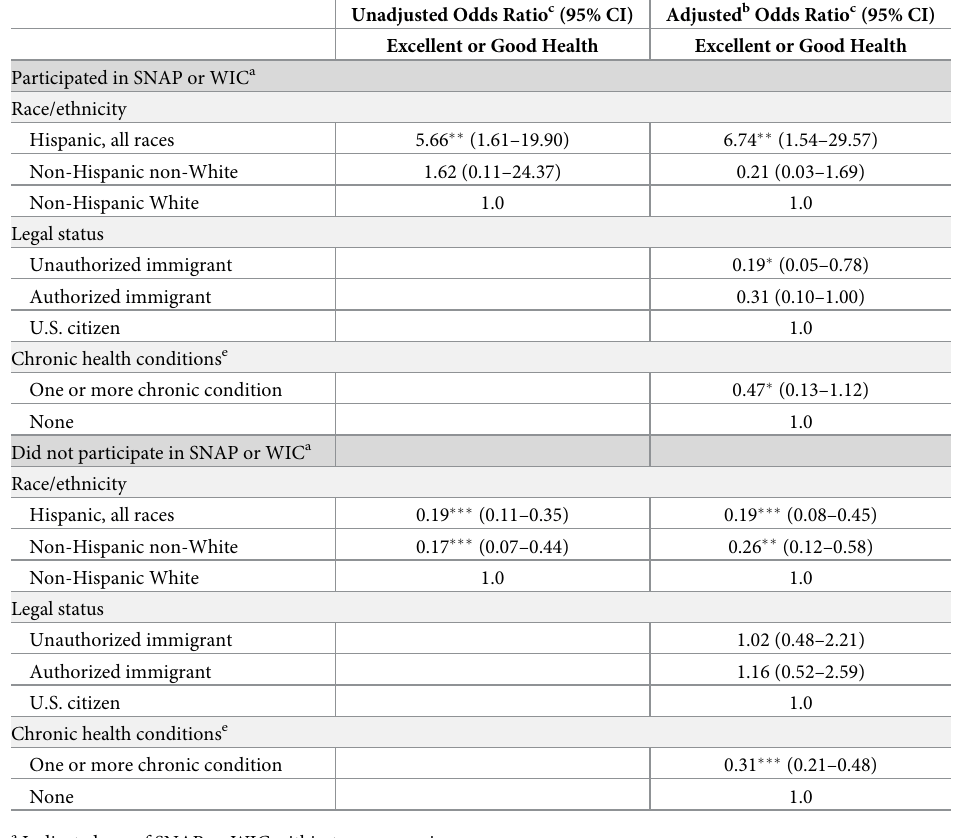
Table 3. Odds of self-reporting excellent or good health vs. fair or poor among U.S. farmworkers by race and eth- nicity, stratified by participation in SNAP or WIC a : National Agricultural Workers Survey (NAWS), 2009/2010 (n =